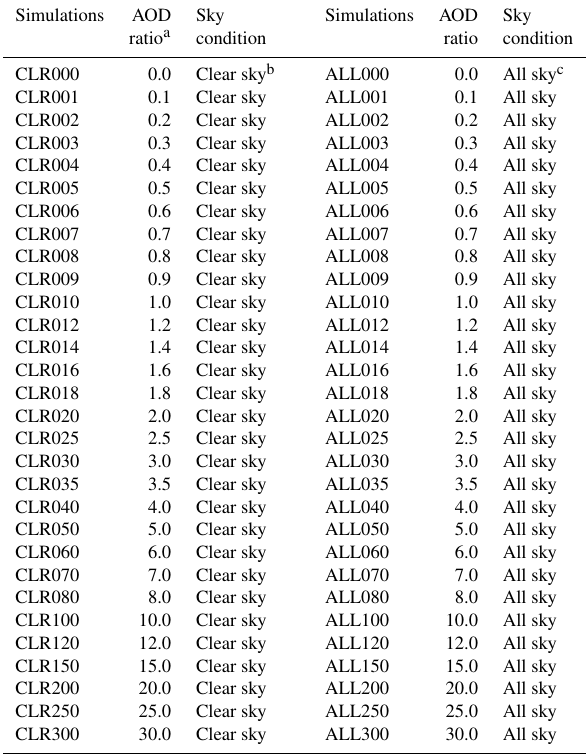
Table 2. Summary of 60 YIBs–CRM simulations.